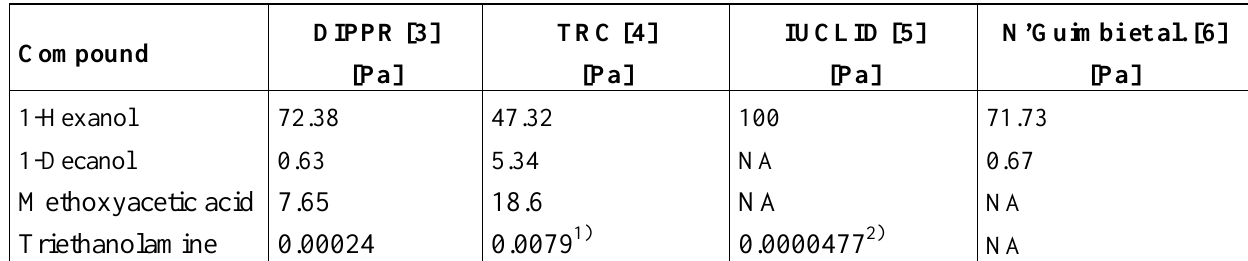
Table 1. Evaluation of some data on vapour pressures at 20 o C